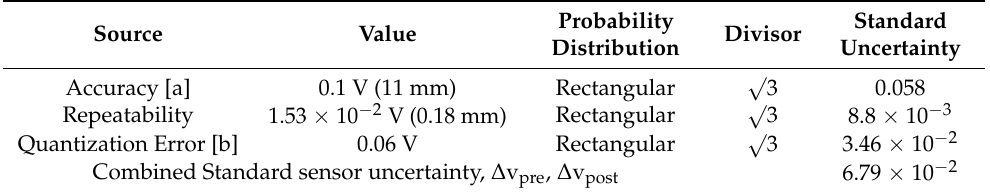
Table 2. Zeroth order uncertainty budget for the ultrasonic sensor (UM30-213113, SICK, Inc., Waldkirch, Germany).